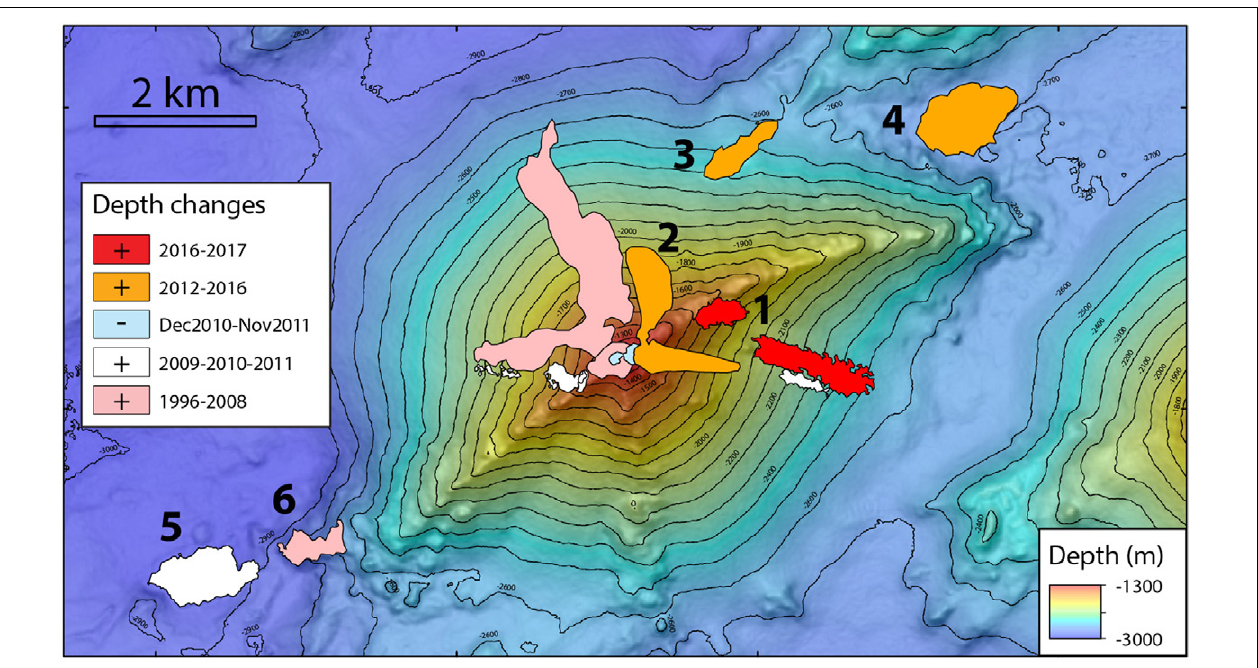
FIGURE 2 | Map of West Mata showing areas where depth changes have been found by repeated bathymetric surveys between 1996 and 2018, documenting recent eruption sites. Those from 1996 to 2012 are from Clague et al. (2011) and Embley et al. (2014); those after 2012 are new (orange and red areas, see legend). The depth changes shown in white are several grouped together within a longer time window (2009–2012) than the time constraints on individual sites (see Embley et al., 2014). The blue areas are negative depth changes from a summit collapse and landslide. Numbers indicate eruption sites discussed in detail in this